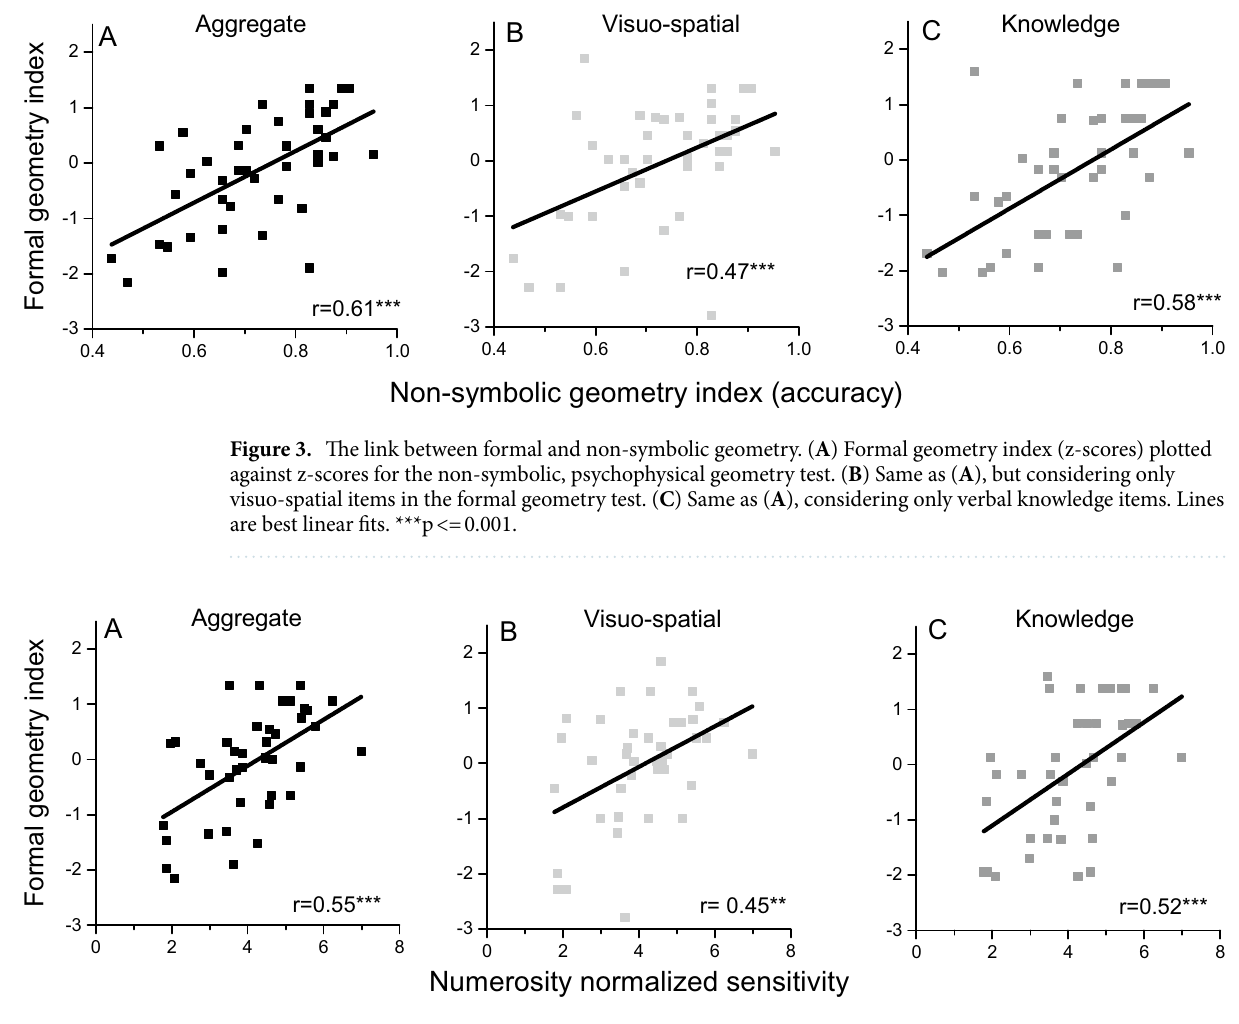
Figure 4. The link between formal geometry and numerosity perception. Z-scores for the formal geometry test plotted as a function of numerosity discrimination sensitivity, considering all the items ( A ), or only visuo-spatial ( B ) or verbal knowledge ( C ). Lines are best linear fit. ***p<=0.001;